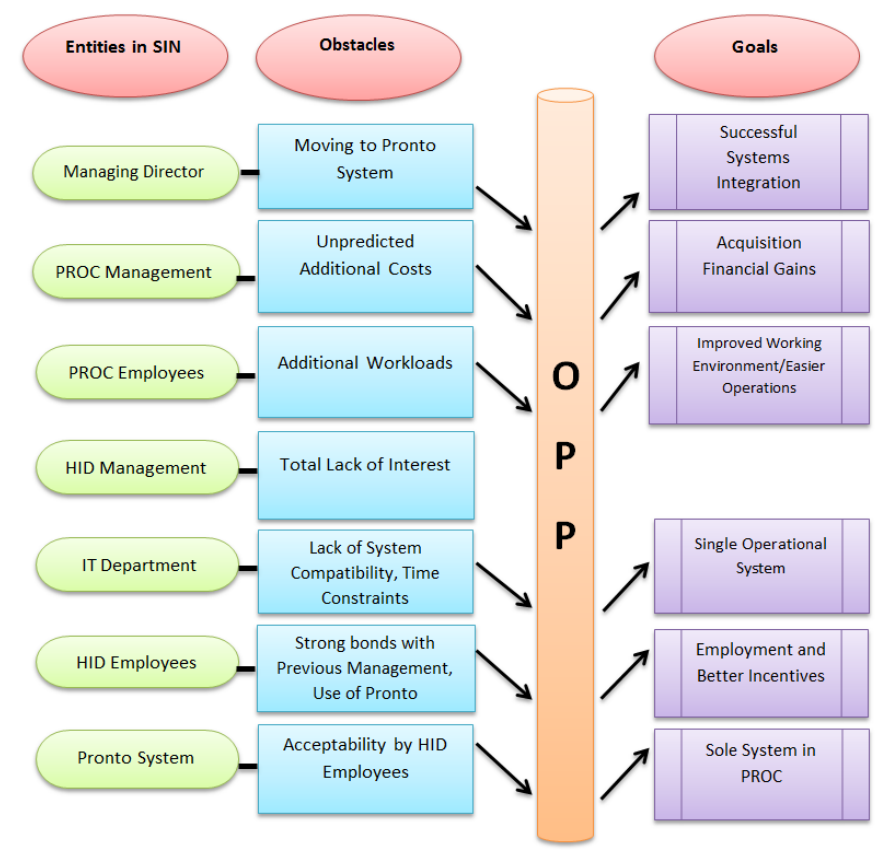
Figure 1. Systems Integration Network entities, their obstacles, OPP 5 and intended goals.